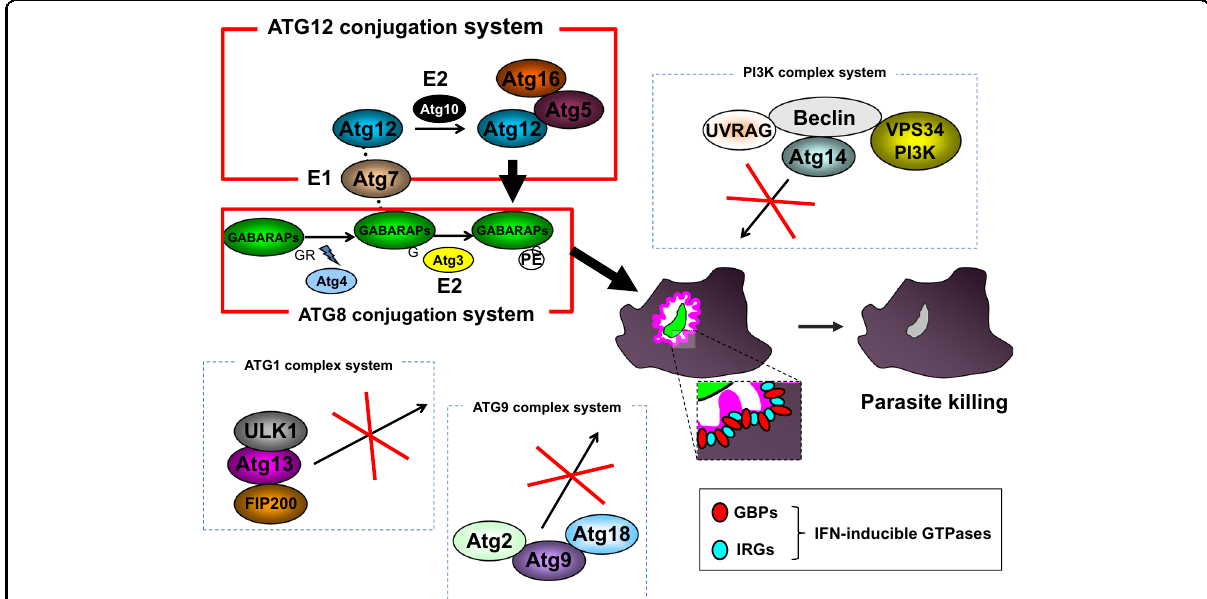
Fig. 2 Diagrams of cell-autonomous immune responses to T. gondii infection. IFN-inducible GTPases, such as GBPs and IRGs, accumulate on the T. gondii PVM and are important for its disruption. ATG family proteins are functionally divided into fi ve systems, Atg12 conjugation, Atg8 modi fi cation, Atg1 complex, PI3K complex and Atg9 complex, which all play differentially critical roles in autophagy. Among them, IFN-inducible GTPase-dependent immunity requires Atg12 conjugation and Atg8 modi fi cation systems (marked red). Atg family members (marked red) regulate the localization of the GTPases that are involved in the destruction of PVMs. GTPases that are reportedly recruited to PVM are IRGs (Irga6, Irgb6, Irgb10 and IrgD) and GBPs (GBP1, GBP2, GBP3, GBP5, GBP6, GBP7 and GBP9). Some GTPases on the PVM form pores on the PVM, resulting in destroying the replication location of T. gondii and preventing the expansion of